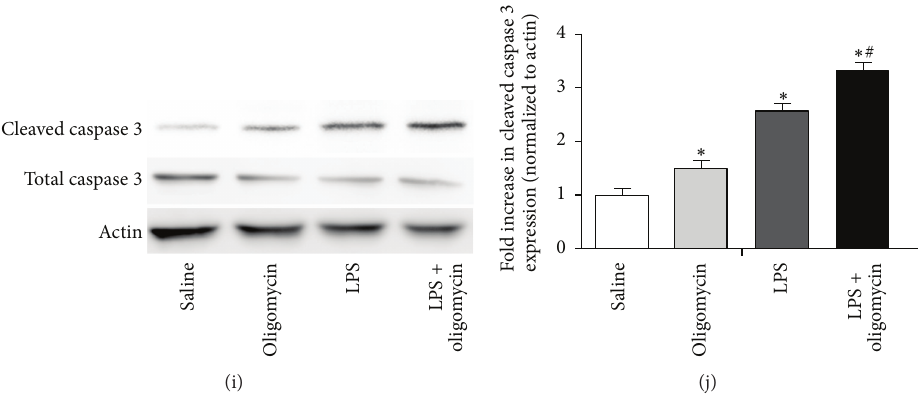
Figure 4: UCP2 enhanced DNA damage and increased caspase-3 cleavage, cytochrome c release, and proapoptotic Bax protein expression but reduced Bcl-2 expression. (a) Western blot showed the expression of cleaved and total caspase-3 from lung tissues of mice in each group. (c) Western blot analysis detected the expression of Bcl-2, Bax, and cytochrome c protein in each group. (b, d–f) Densitometric analysis of these proteins immunoreactive bands is shown as fold difference normalized to actin expression. (g) The percentage of apoptotic positive cells was detected by the TUNEL assay. (h) The mitochondrial ATP levels were measured by a luciferase-based assay after oligomycin (1mg/kg) preinjection in mice. (i) Western blot analysis detected the expression of cleaved and total caspase-3. (j) Densitometric analysis of cleaved caspase-3 proteins immunoreactive bands is shown as fold difference normalized to actin expression. ( ∗ 𝑃 < 0.05 versus the UCP2-NC + saline group, # 𝑃 < 0.05 versus the UCP2-NC + LPS group, $ 𝑃 < 0.05 versus the saline group, and + 𝑃 < 0.05 versus the LPS group). Values are presented as means ± SEM ( 𝑛 = 3